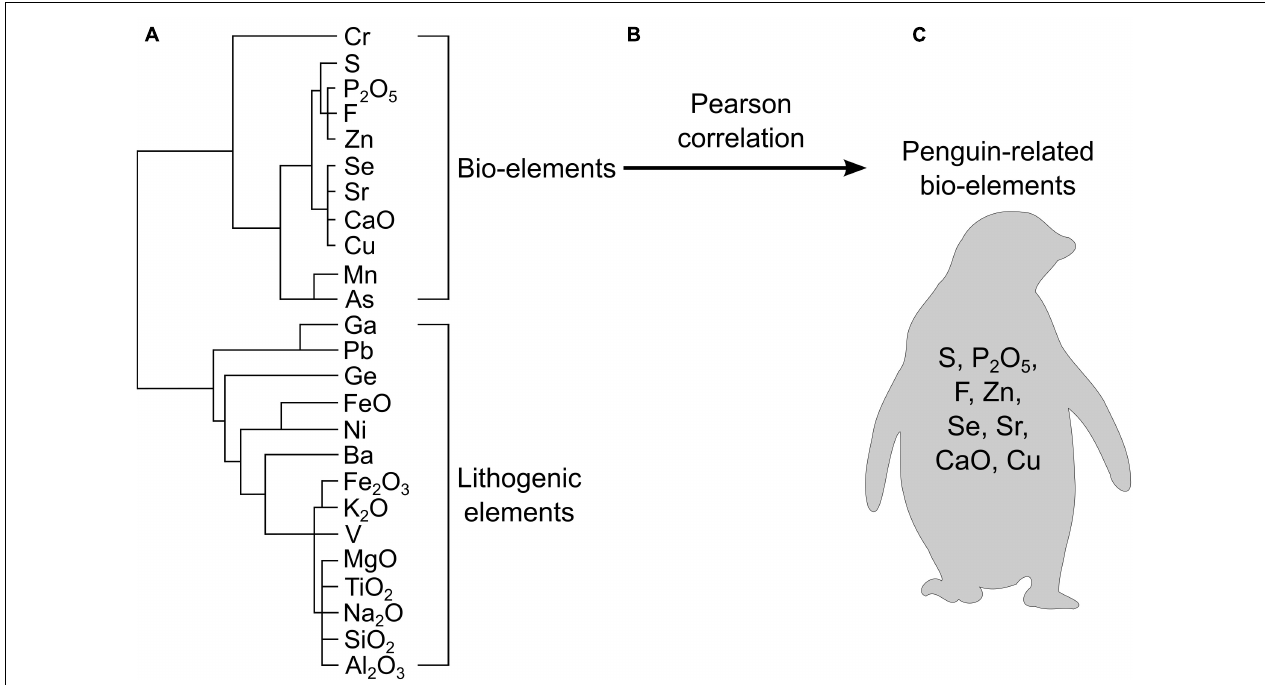
FIGURE 3 | A workflow diagram illustrating how one may evaluate which elements are likely related to a biovector using R-cluster analysis. This example uses data from Liu et al. (2005) where authors determined that S, P 2 O 5 , F, Zn, Se, Sr, CaO, and Cu were related to penguin inputs. (A) R-cluster analysis creates a dendrogram of all measured elements. Major groups are determined based on their linkage distance and compared to known fecal data from the bird-of-interest to determine which grouping represents bio-elements. (B) A Pearson correlation is used to corroborate that the elements are of similar origins. (C) The resulting grouping of elements are positively correlated and represent input from the bird-of-interest.